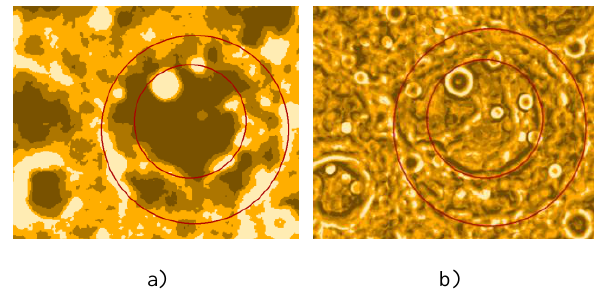
Figure 5. The morphology of Homer crater, obtained by processing of DEM on Kuiper quadrant (222 m / pixel)